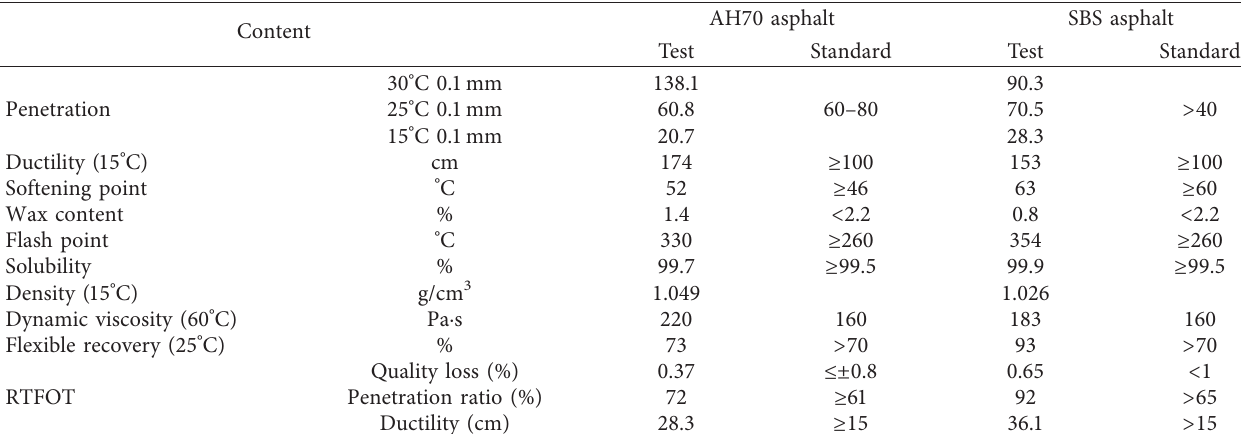
Figure 1: Asphalt for test. (a) AH70 asphalt. (b) SBS asphalt. (c) BRA. (d) TLA. Table 1: Basic properties of AH70 asphalt and SBS asphalt.